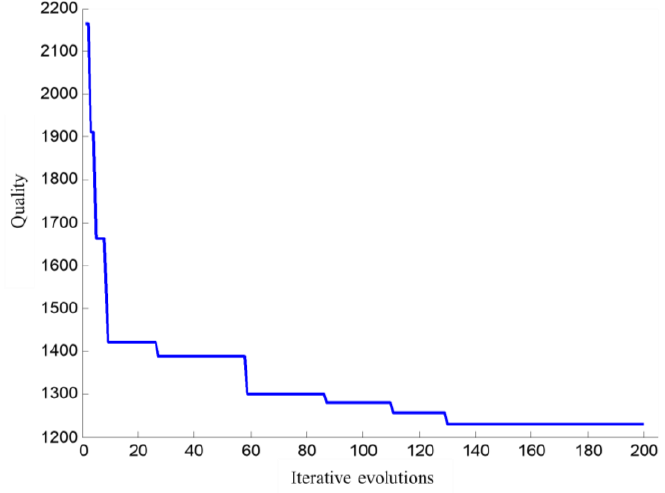
Figure 4. Iterative graph of structural quality optimization.